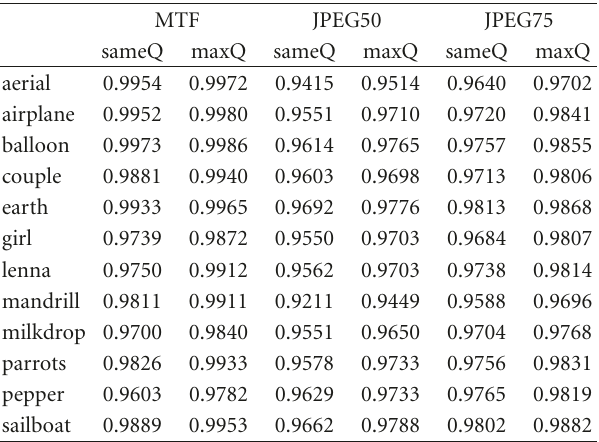
Table 5: MSSIM between watermarked images and lower limit